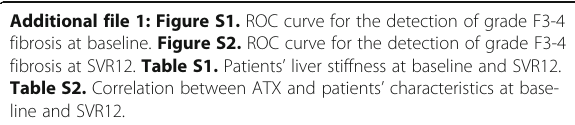
Additional file 1: Figure S1. ROC curve for the detection of grade F3-4 fibrosis at baseline. Figure S2. ROC curve for the detection of grade F3-4 fibrosis at SVR12. Table S1. Patients ’ liver stiffness at baseline and SVR12. Table S2. Correlation between ATX and patients ’ characteristics at base- line and SVR12.